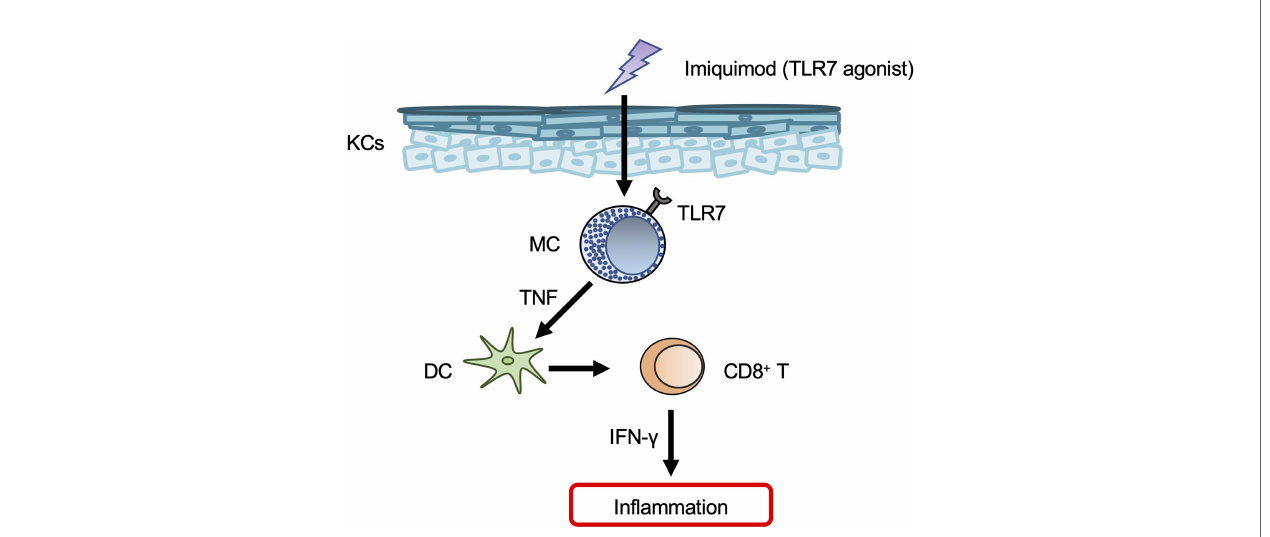
FIGURE 4 | Mast cells in psoriasis. Mast cells (MCs) produce TNF in response to imiquimod via TLR7, and TNF then promotes dendritic cell (DC) migration from the skin to draining LNs. The migrated DCs induce CD8 + T-cell expansion in the peripheral